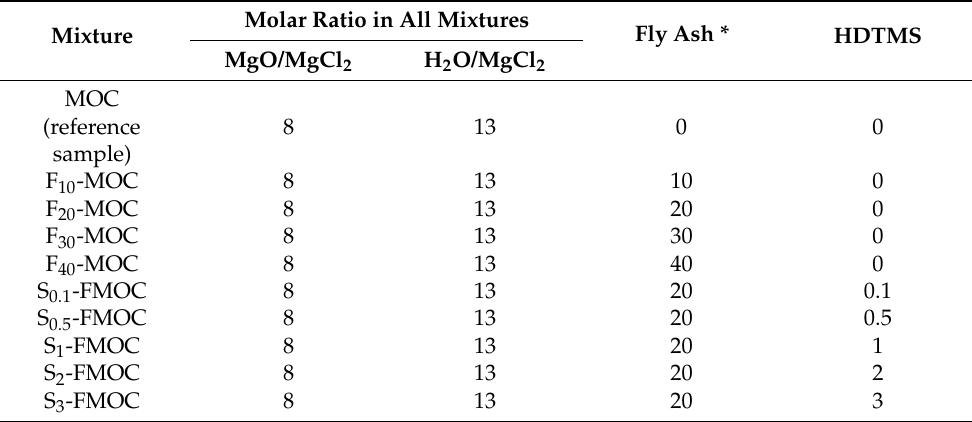
Table 3. Sample proportions in a MOC mixture (wt%, by mass of